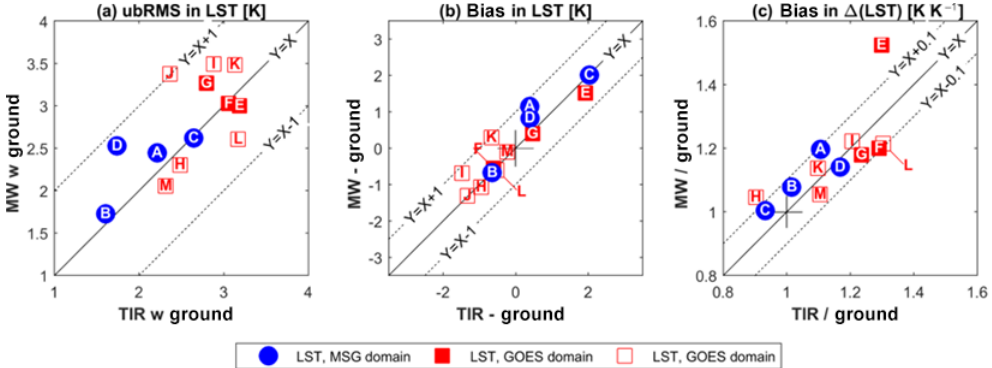
Figure 2. Comparison between TIR-LST ( x axis) and MW-LST ( y axis) in terms of their validation metrics with station LST for frost-free and cloud-free days. From left to right the three panels show (a) ubRMSE, (b) mean bias and (c) bias in (cid:49) (LST). Each marker represents the statistics as calculated for individual locations as identified by the letter (see Table 1 for definition). For the GOES domain the filled markers highlight the stations used in the cloud analysis. Black lines provide visual support and indicate targets (e.g., 1 : 1 line, cross at zero